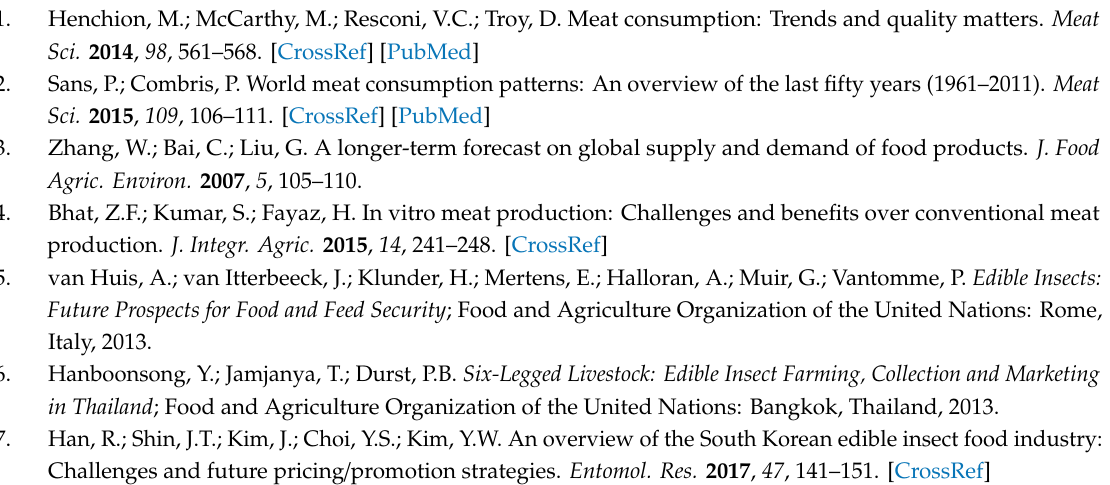
Supplementary Materials: The following materials are available online, Table S1: Retention times (t R ) and multiple reaction monitoring (MRM) transition profiles including the m / z values of precursors and product ions, declustering potential (DP), entrance potential (EP), collision energy (CE), and cell exit potential (CXP) for 353 target compounds; Table S2: Recovery results of representative pesticides that showed a di ff erence in recovery rate depending on number of acetonitrile-hexane partition rounds ( N = 1, 2, and 3); Table S3: Comparison of four QuEChERS extraction combinations and distribution of recovery results for 353 target pesticides; Table S4: Recovery results of representative pesticides that showed di ff erent recovery rate depending on dSPE sorbent combination (PSA + C18, PSA, and C18). Figure S1: Mealworms grown in wheat